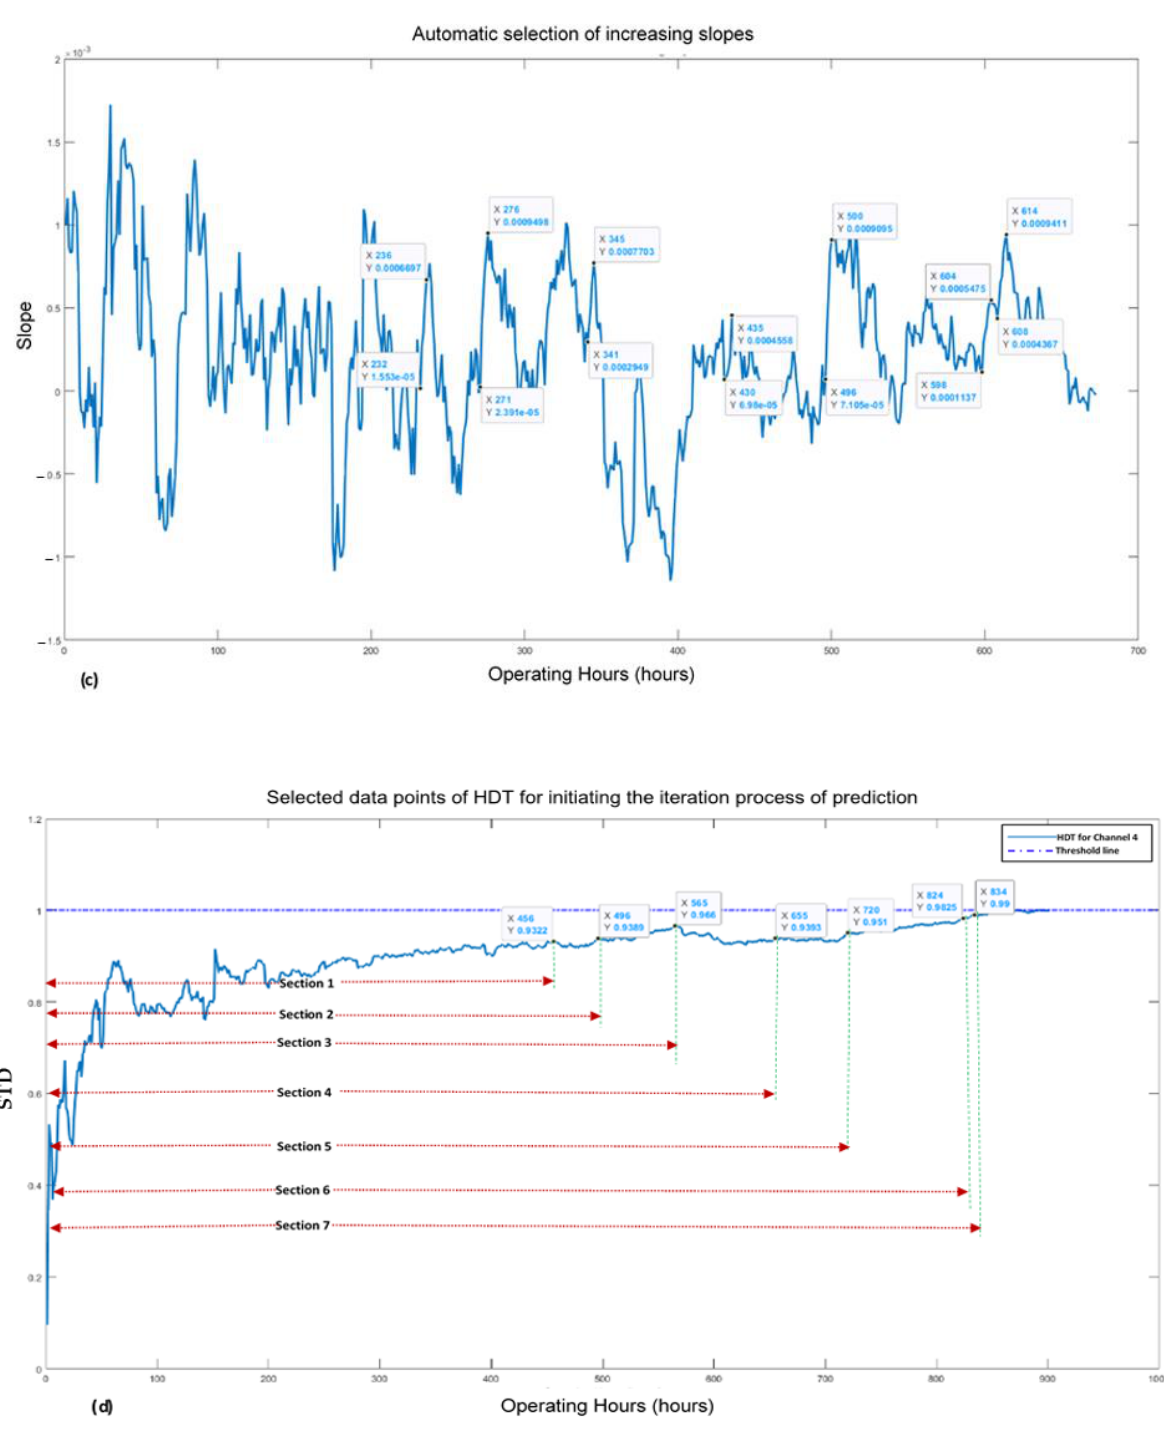
Figure 5. Increasing trends of slope points ( a , c ) and selected data points of HDTs ( b , d ) for channel and channel 4, 2 and channel 4, respectively.